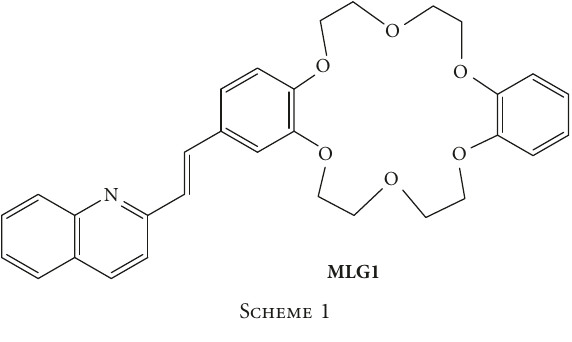
Table 2: Truth tables resulting from MLG1 using irradiation, H + , and Ca 2+ inputs and the emission mode as output. a